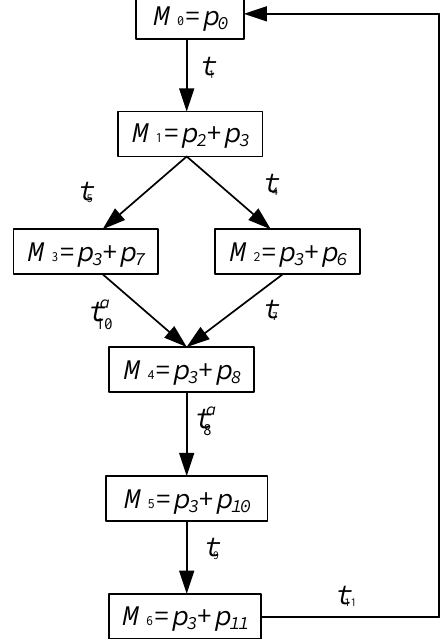
Figure 7. G B : the basis attack